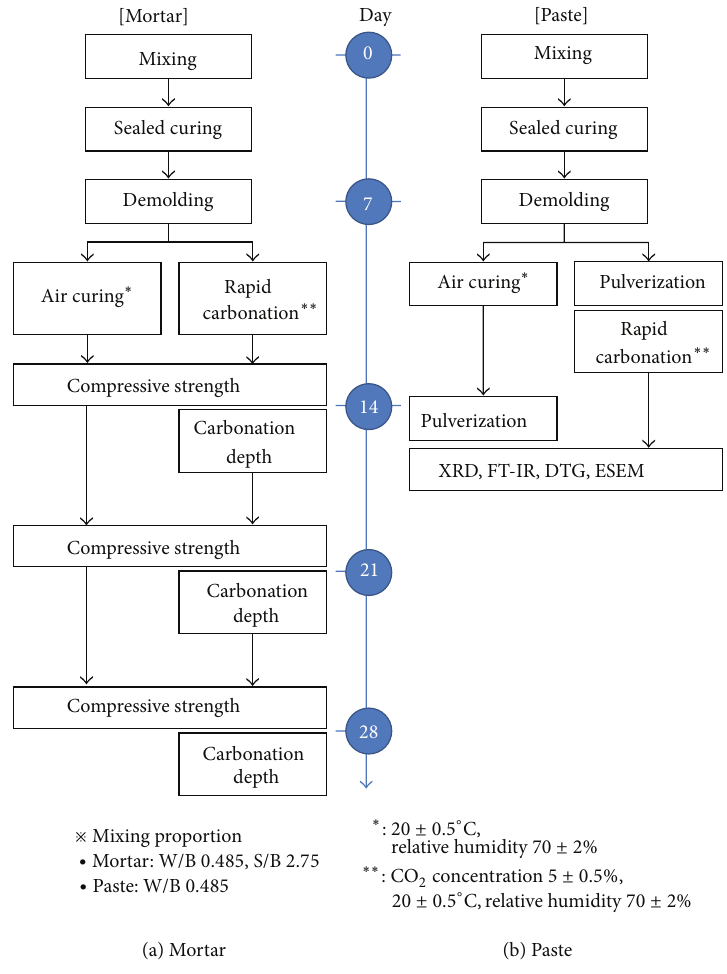
Figure 1: Experimental